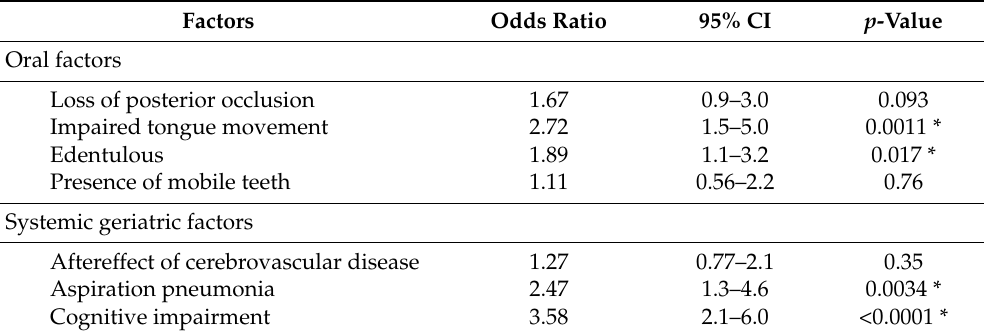
Table 2. Several factors due to which the elderly patients cannot return home after